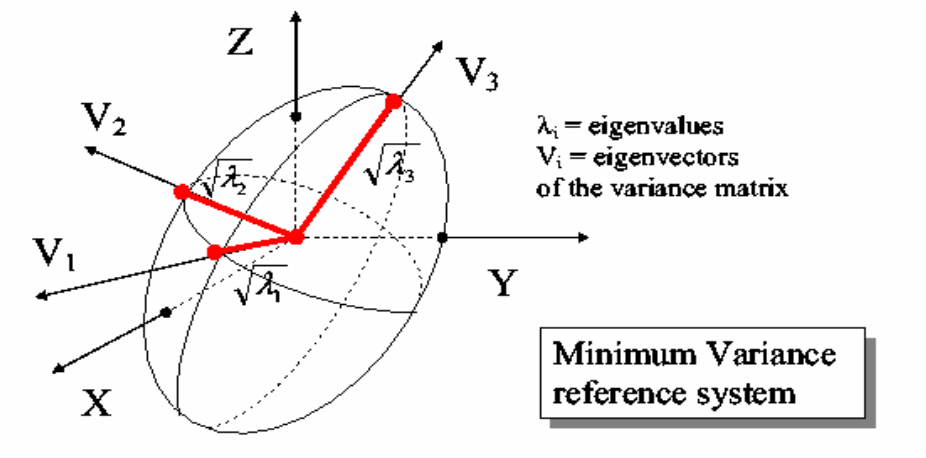
Figure 119: Original reference system [ 𝑥, 𝑦, 𝑧 ] and minimum variance reference system whose axes are 𝑉 1 , 𝑉 2 , and 𝑉 3 and represent the eigenvectors of 𝑀 . Moreover, 𝜆 1 , 𝜆 2 , and 𝜆 3 are the eigenvalues of 𝑀